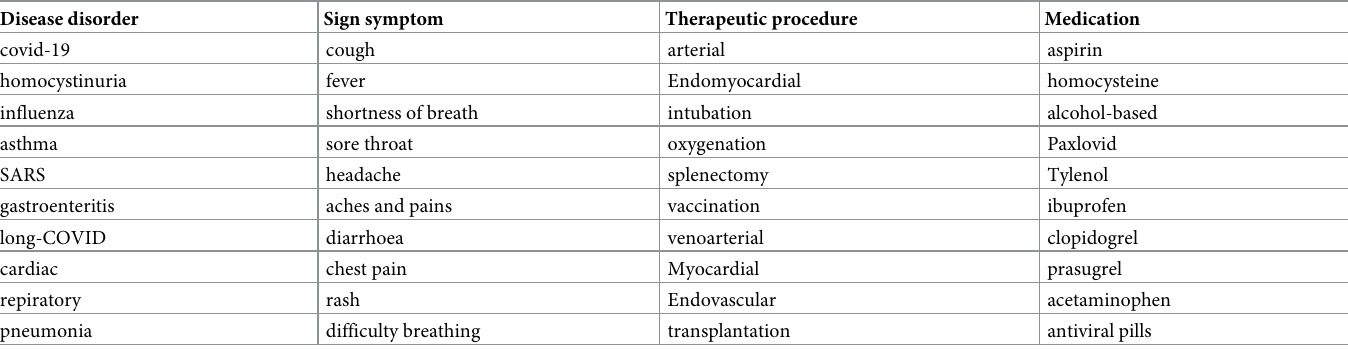
Table 6. Most frequent named entities from 100 covid-19 case